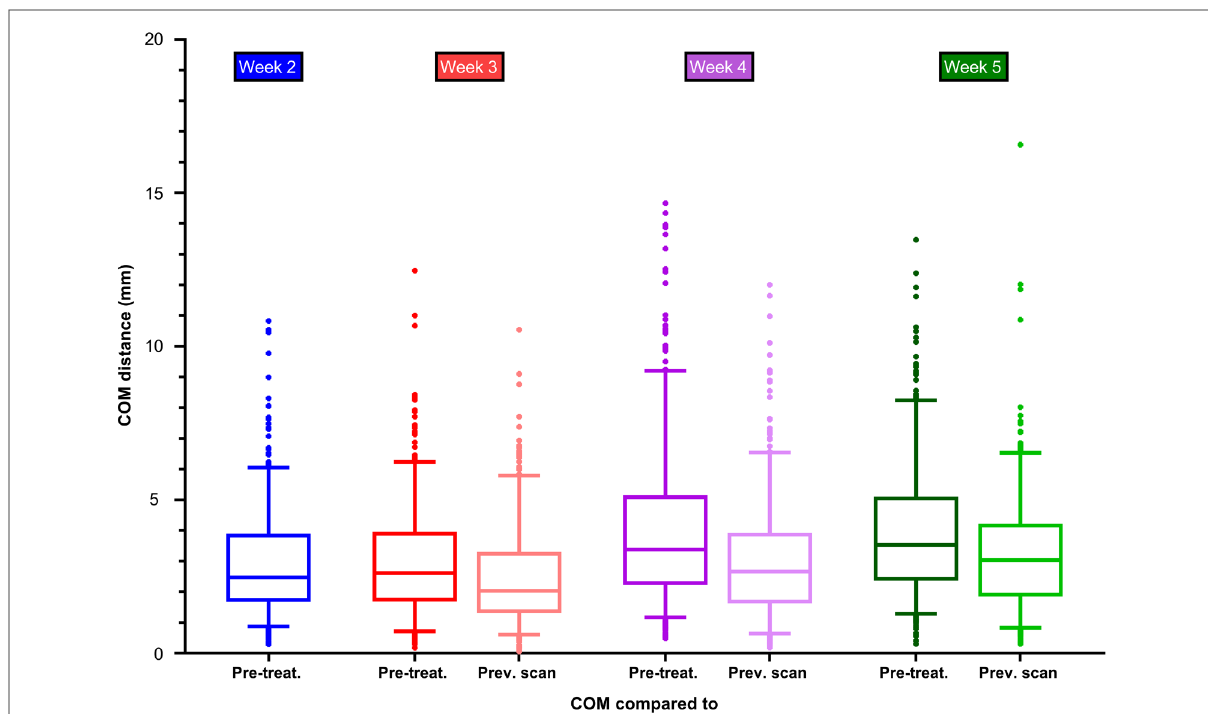
FIGURE 4 Centre of mass distance between delineations of elective lymph nodes in the pre-treatment scan and the delineations in the scans of week 2, 3, 4 and 5 during radiotherapy. The centre of mass was compared to the pre-treatment scan and to the previous scan.